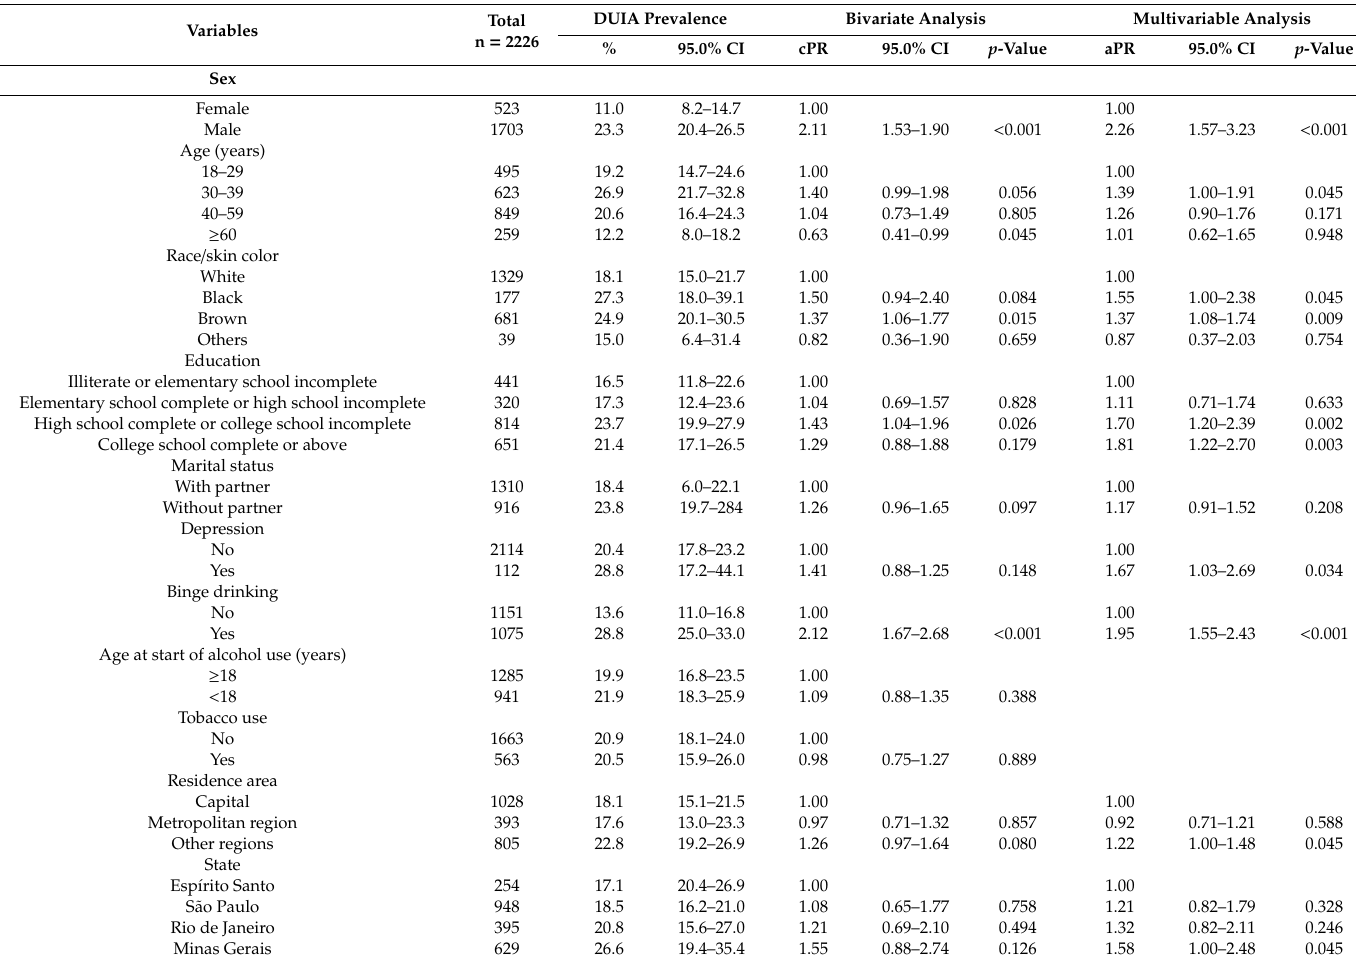
Table 2. Prevalence and Factors Associated with Driving Under the Influence of Alcohol in Southeast Brazil. National Health Survey,